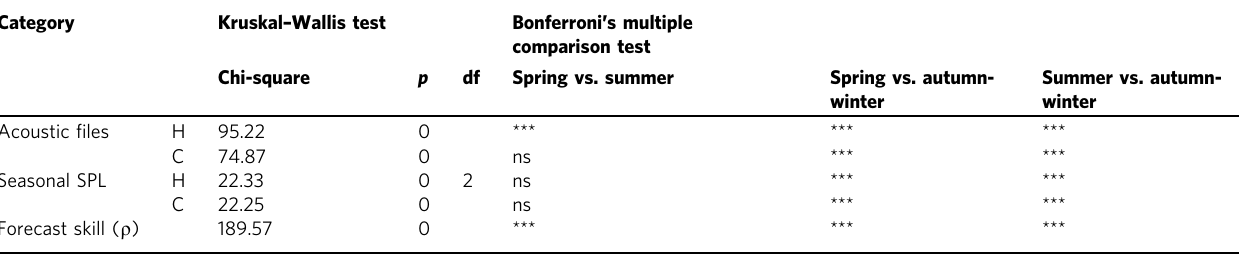
Table 1 Summary statistics and multi-level comparisons for different seasons. Category